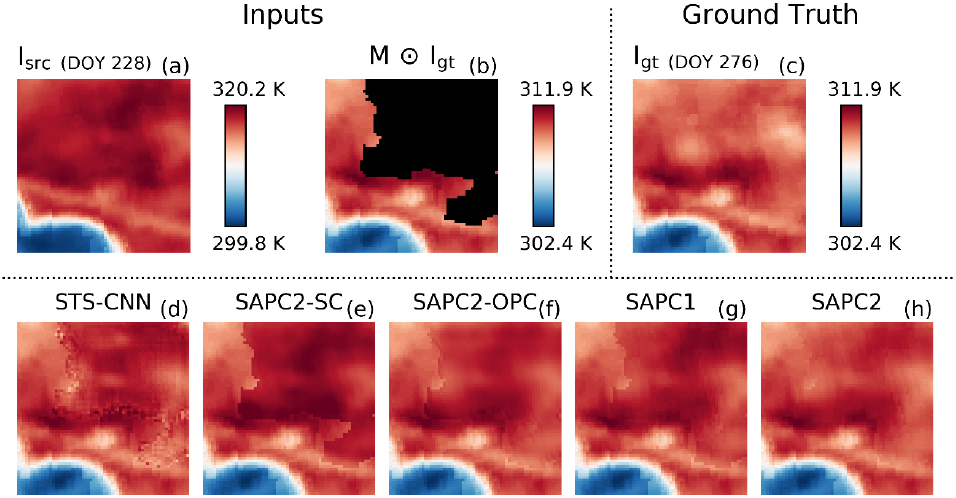
Figure 9. Model predictions comparison, Case 1: ( a ) the input source image (acquired on day of year (DOY) 228); ( b ) the masked target image (acquired on DOY 276) with the black color highlights the masked part; ( c ) the ground truth (complete target) image (also acquired on DOY 276); ( d – h ) mosaicked model predictions for the four baseline models (i.e., left to right: STS-CNN, SAPC2-SC, SAPC2-OPC, and SAPC1) and for the proposed model (i.e., SAPC2). All model predictions share the same color bar as that of the ground truth ( c ). Note that the color bars are independent between the source and the target (or the ground truth). The masked fraction of the target image ( b ) is 0.476. The correlation coefficient between source ( a ) and ground truth ( c ) images is 0.957.